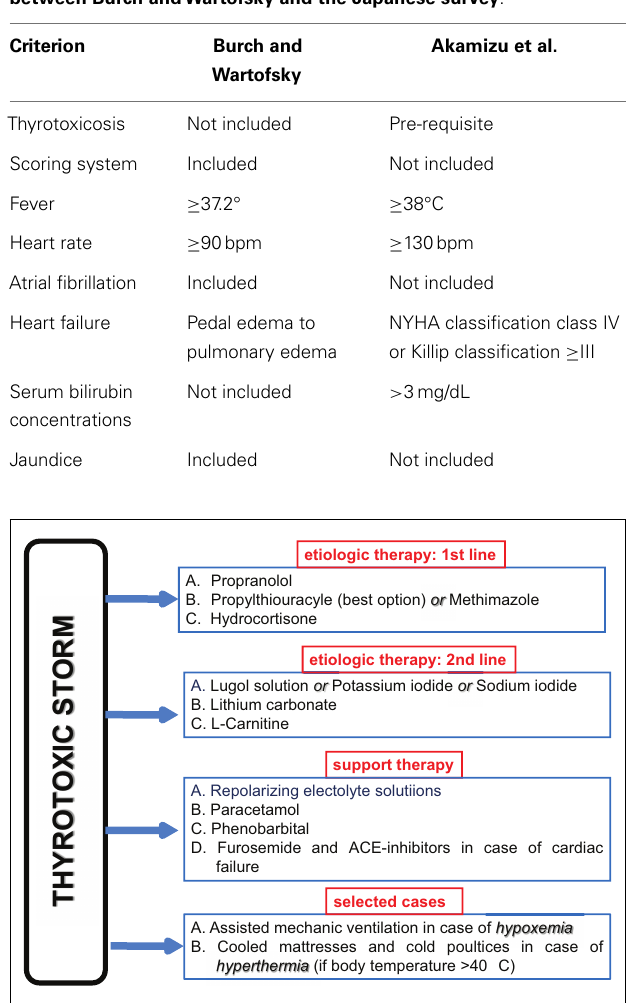
FIGURE 2 | Specific and support therapy in patients with thyroid storm .